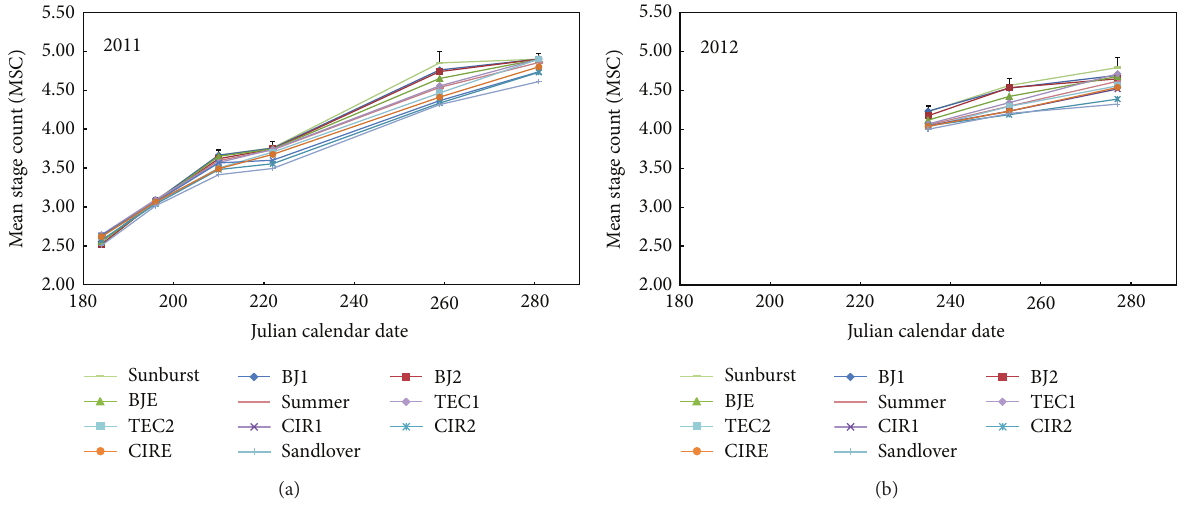
Figure 5: Mean stage count of 11 selections of switchgrass at Sainte-Anne-de-Bellevue, Quebec, in 2011 and 2012. Vertical bars represent the least significant difference (LSD, 𝑃 = 0.05 ) at each sampling point throughout the season. BJ1, Blue Jacket; BJ2, Blue Jacket II; BJE, Blue Jacket Early; TEC1, Tecumseh; TEC2, Tecumseh II; CIR, Cave-in-Rock; CIR2, Cave-in-Rock II; CIRE, Cave-in-Rock Early.